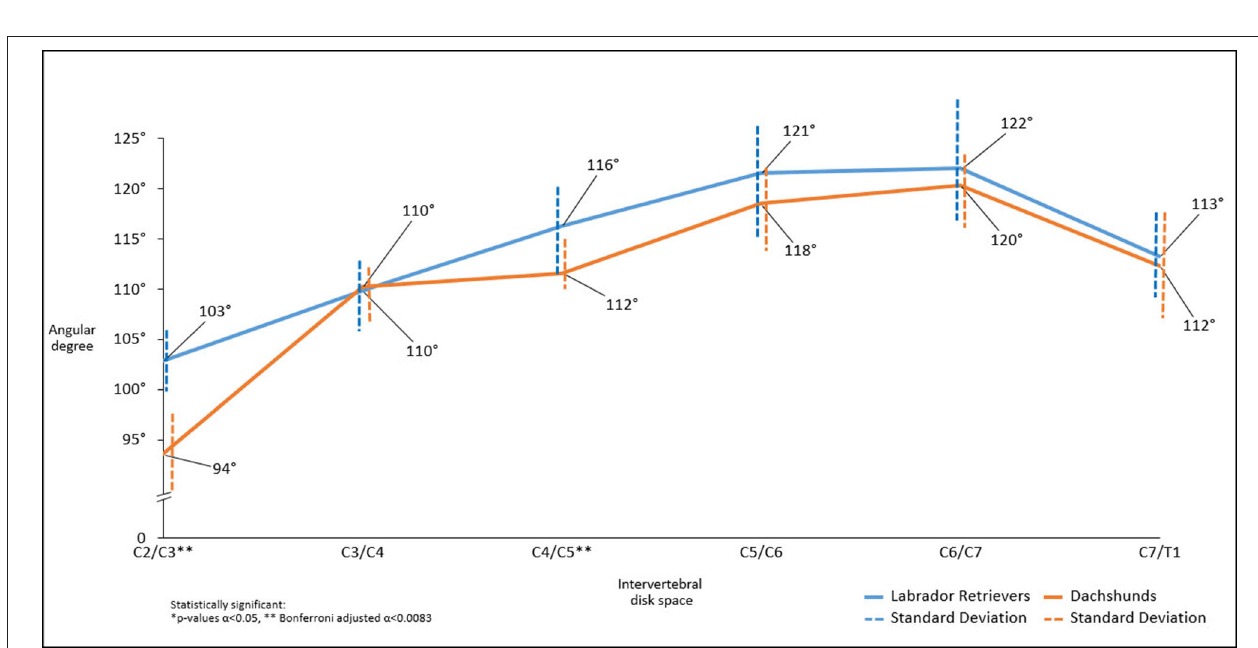
FIGURE 4 | Line graph showing mean dorsal-to-ventral paraspinal musculature height ratio along cervical spine of Dachshunds (orange) and Labrador Retrievers (blue) measured in sagittal plane computed tomographic images. For accurate presentation, measurements pictured are rounded to one decimal place.